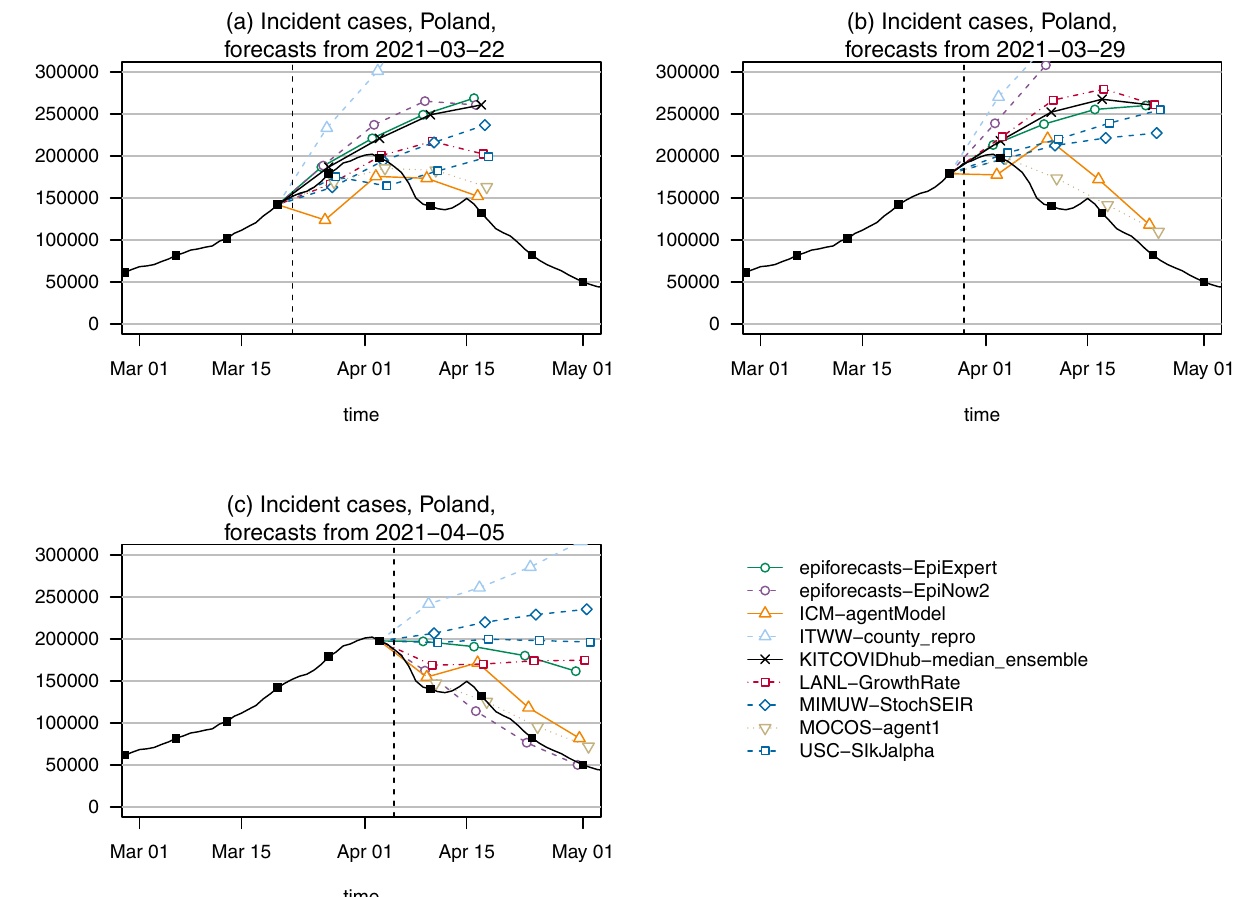
Fig. 6 Case forecasts in Poland surrounding the peak in April 2022. Point forecasts of cases in Poland from a 22 March, b 29 March, and c 5 April 2021, surrounding the peak week. In each panel, the date at which forecasts were created is marked by a dashed vertical line. The models ICM-agentModel and MOCOC-agent1 anticipated the trend change correctly, while the remaining models show more or less pronounced